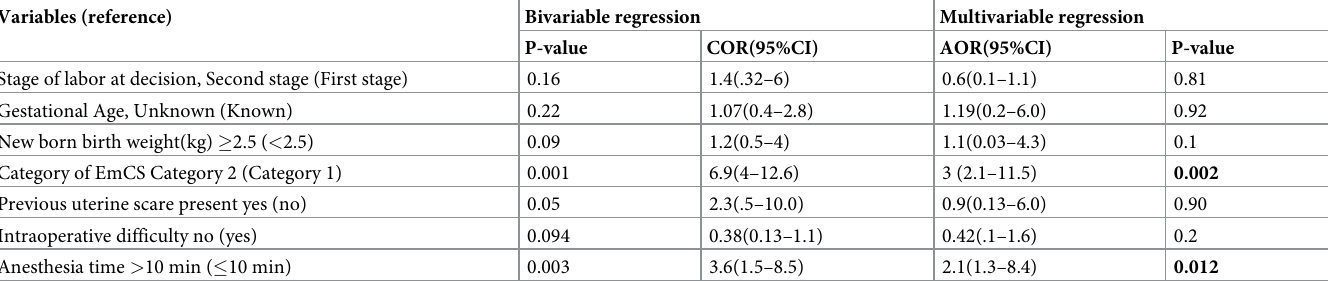
Table 4. Predictors of decision to delivery time intervals, in Bahir Dar City Public Hospitals, Ethiopia, 2020 (n = 182). Variables (reference)